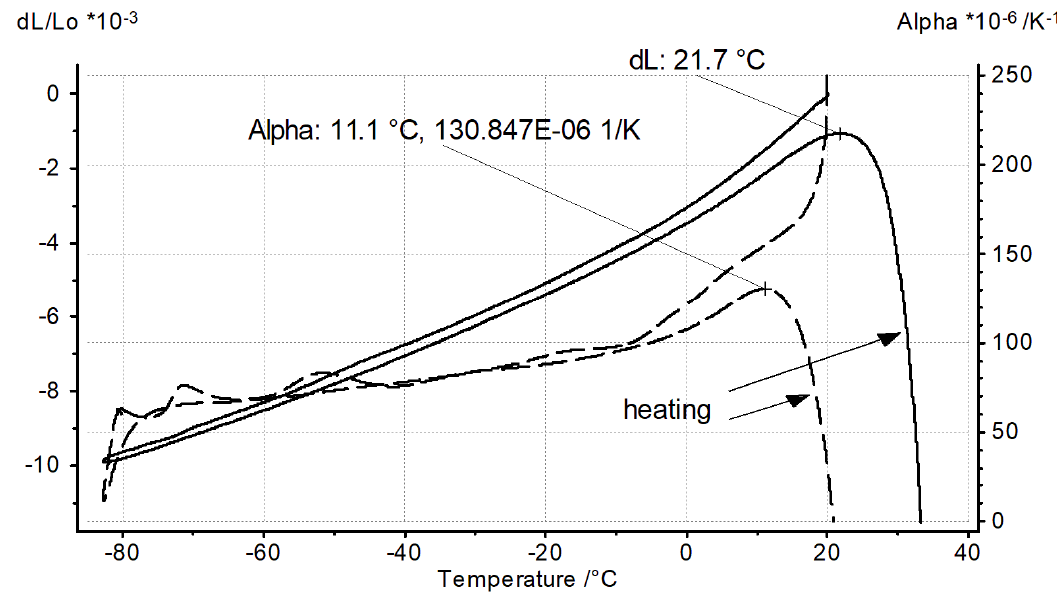
Figure 5. Results of dilatometric investigation of the TSP bulk specimens manufactured by drying the liquid substrate poured into a mold (solid line—linear expansion; dashedline—coefficient of linear thermal expansion).